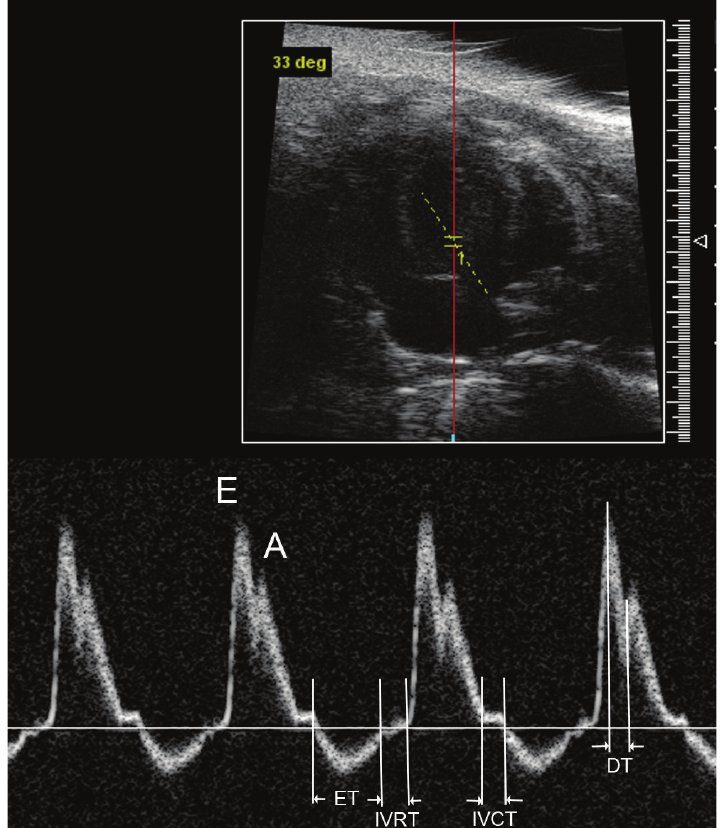
Figure 3: Mitral pulse Doppler tracings obtained on a wild type mouse. E, E wave indicating early ventricular filling; A, A wave indicating late filling caused by atrial contraction; ET, ejection time; IVRT, isovolumetric relaxation time; IVCT, isovolumetric contraction time; DT, deceleration